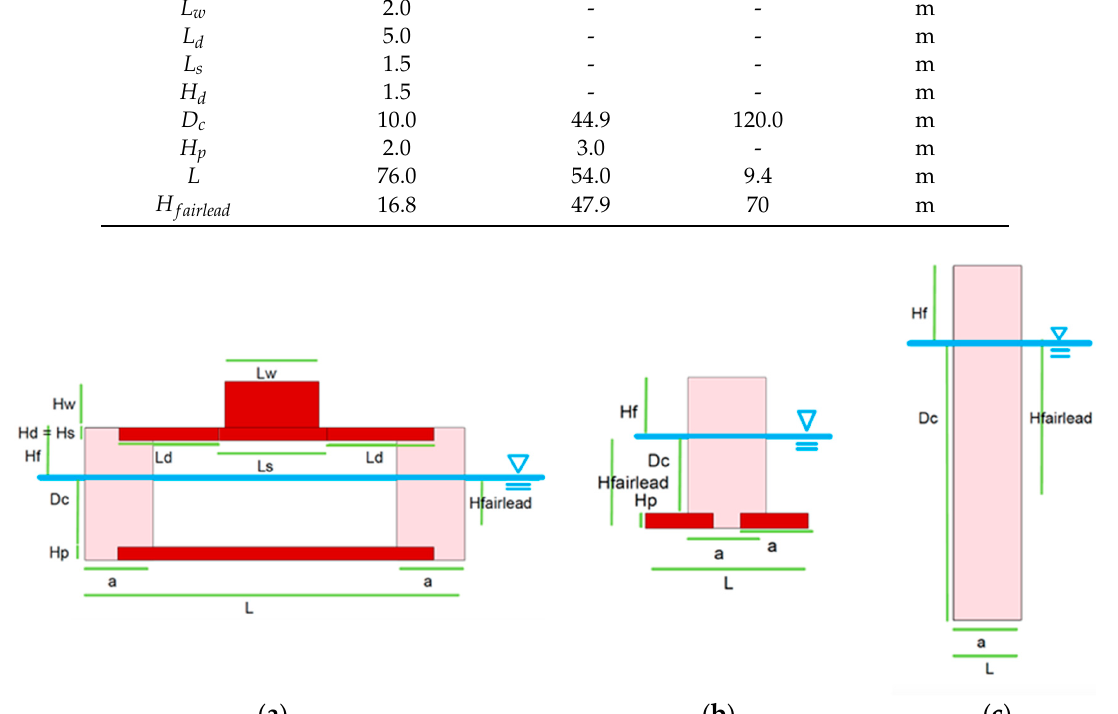
Figure 6. Dimensions of the semisubmersible platform ( a ), the TLP platform ( b ), and the spar platform